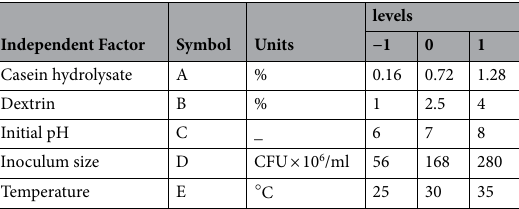
Table 3. Summary of BBD used for AuNPs biosynthesis, using Bacillus subtilis NRC1 extracellular